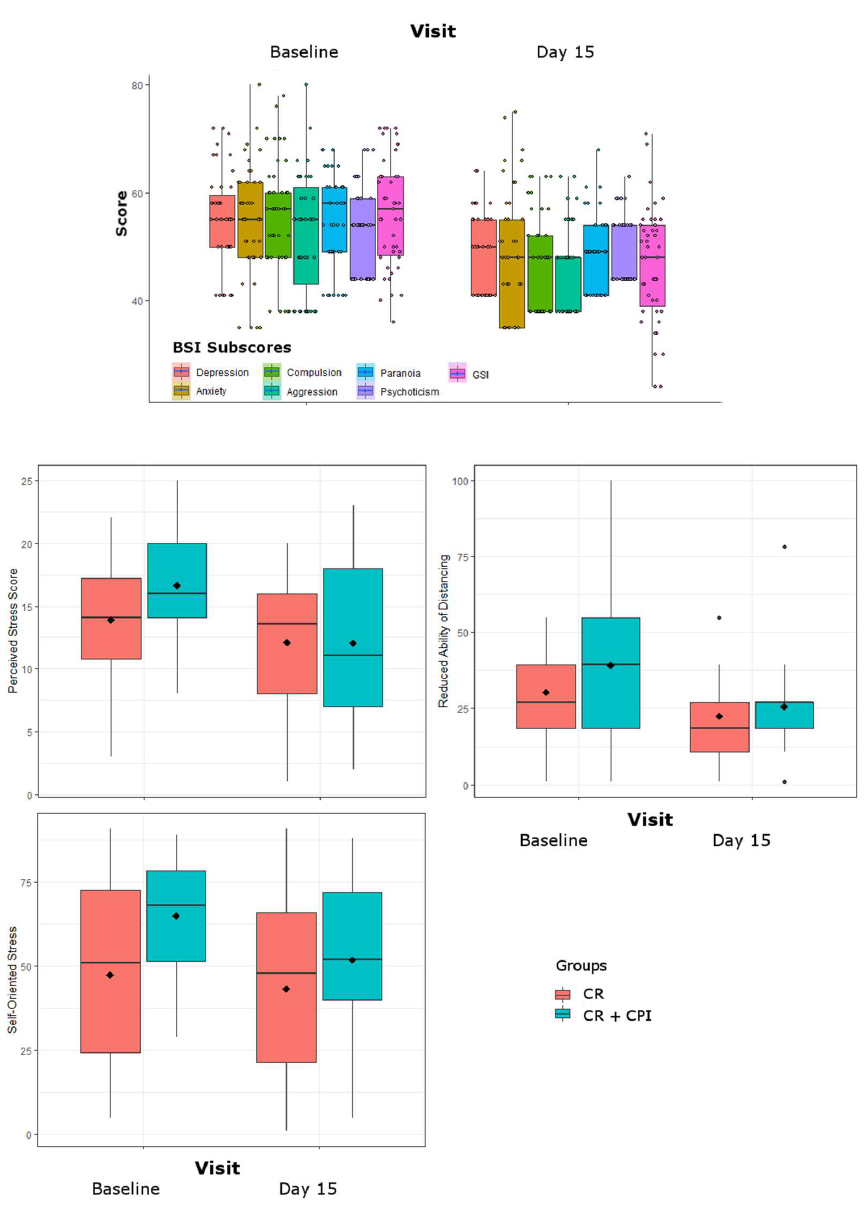
Figure 4. Changes in psychometric parameters over the study period of 14 days. Dimensional values of the brief symptom inventory (BSI) are provided for the two study timepoints as well as the global severity index (GSI). Results for the BODI Item 3 (reduced ability of distancing), the BODI self-rating of self-oriented stress and the perceived stress scale total score are grouped by treatment groups of caloric restriction (CR) alone and CR together with clinical psychological intervention (CPI).